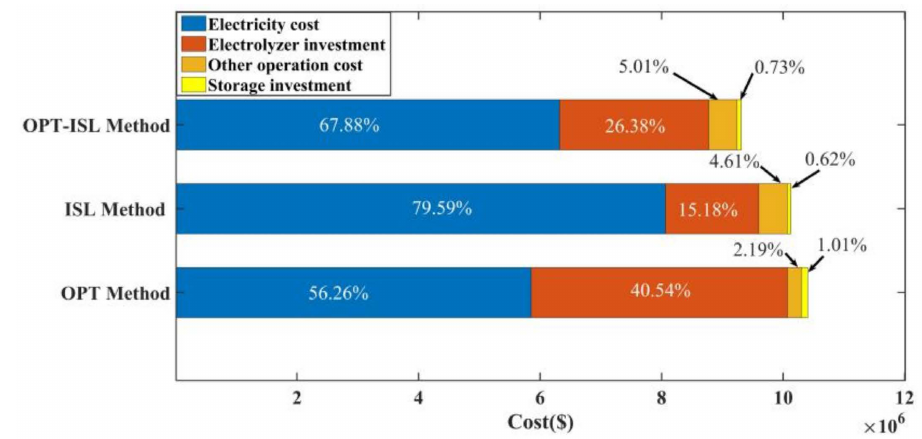
Figure 10. Percentage of HRS expenses in a year with the three configuration